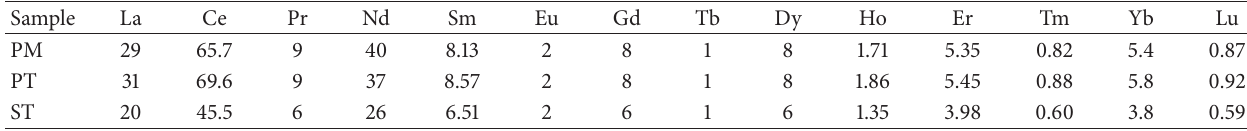
Table 3: REE trace elements (expressed as ppm) by ICP MS.